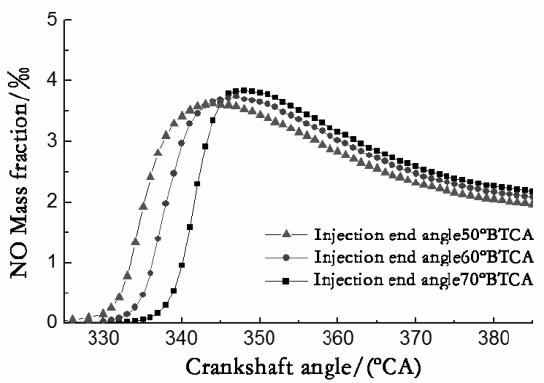
Figure 15. NO curves corresponding to different injection end angles.